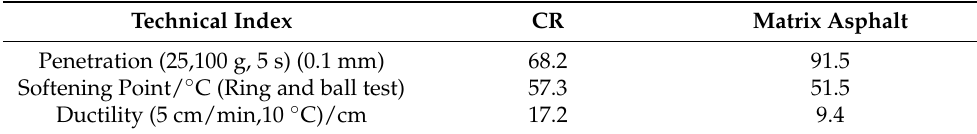
Table 1. Technical indices of CR and matrix